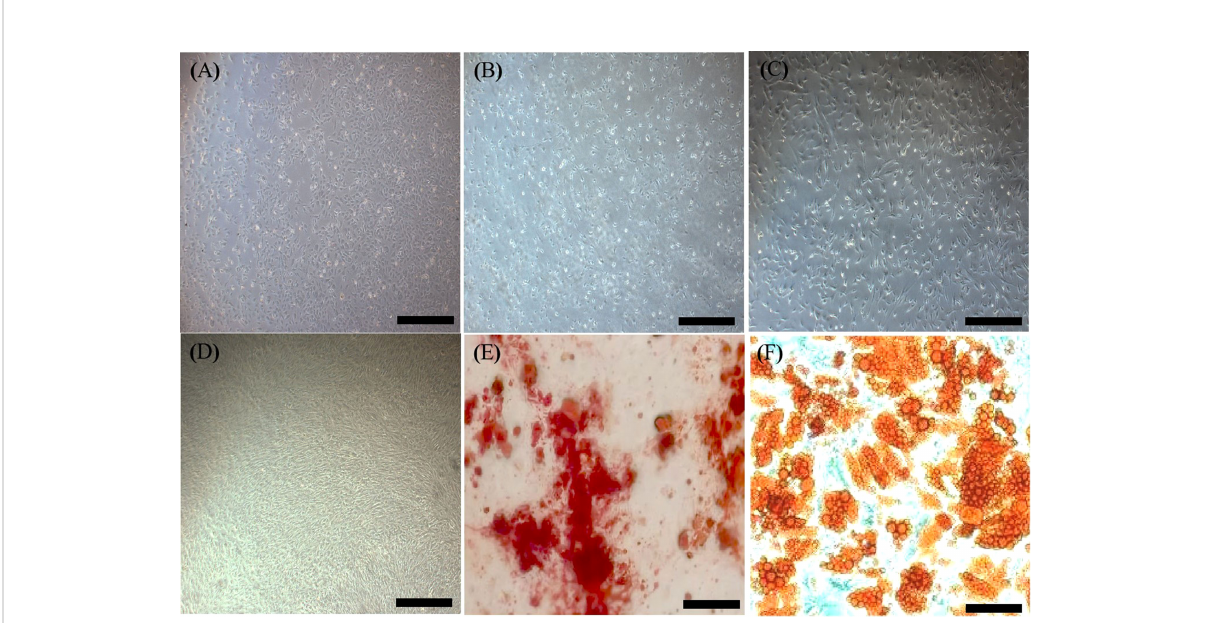
FIGURE 4 Characterization of MSCs. (A) , First generation MSCs (×40, Scale bar=400 µm.). (B) , Third generation MSCs (×40, Scale bar=400 µm.). (C) , Fifth generation MSCs with a regular shape (×40, Scale bar=400 µm.). (D) , Tenth generation MSCs (×40, Scale bar=400 µm.). (E) , Alizarin red staining showing osteogenesis (×100, Scale bar=200µm.). (F) , Oil red O staining showing adipogenesis (×100, Scale bar=200µm.). MSCs, mesenchymal stromal